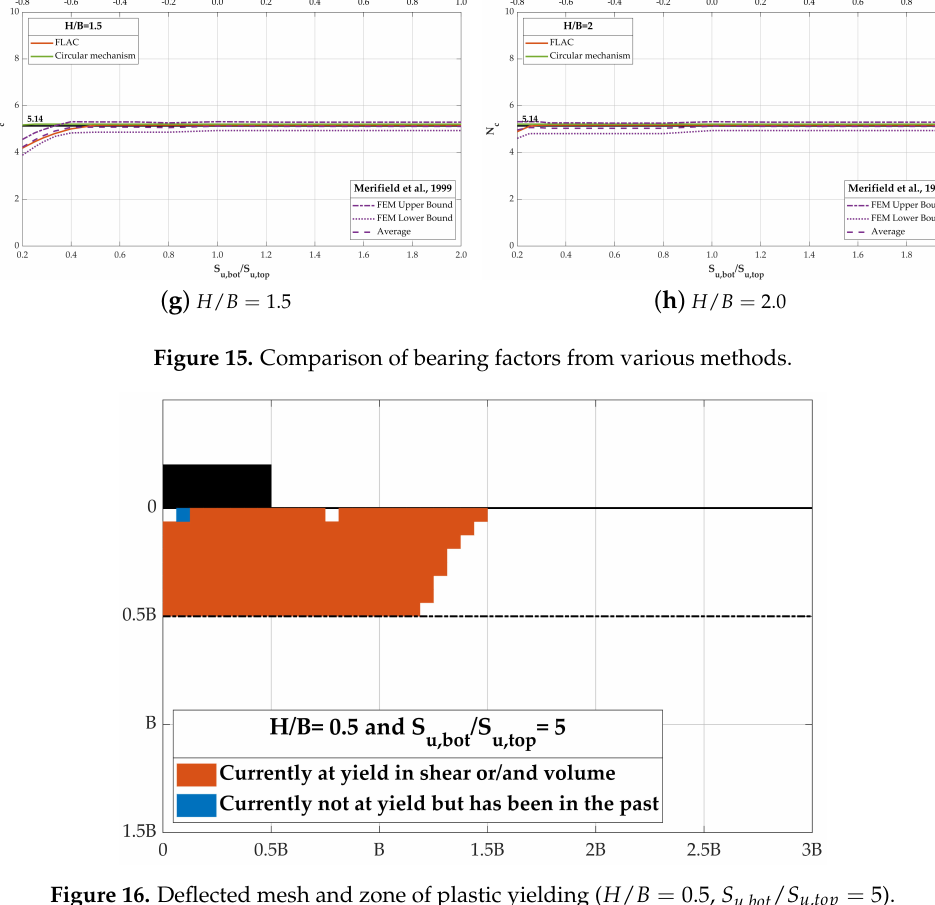
Figure 16. Deflected mesh and zone of plastic yielding ( H / B = 0.5, S u , bot / S u , top =